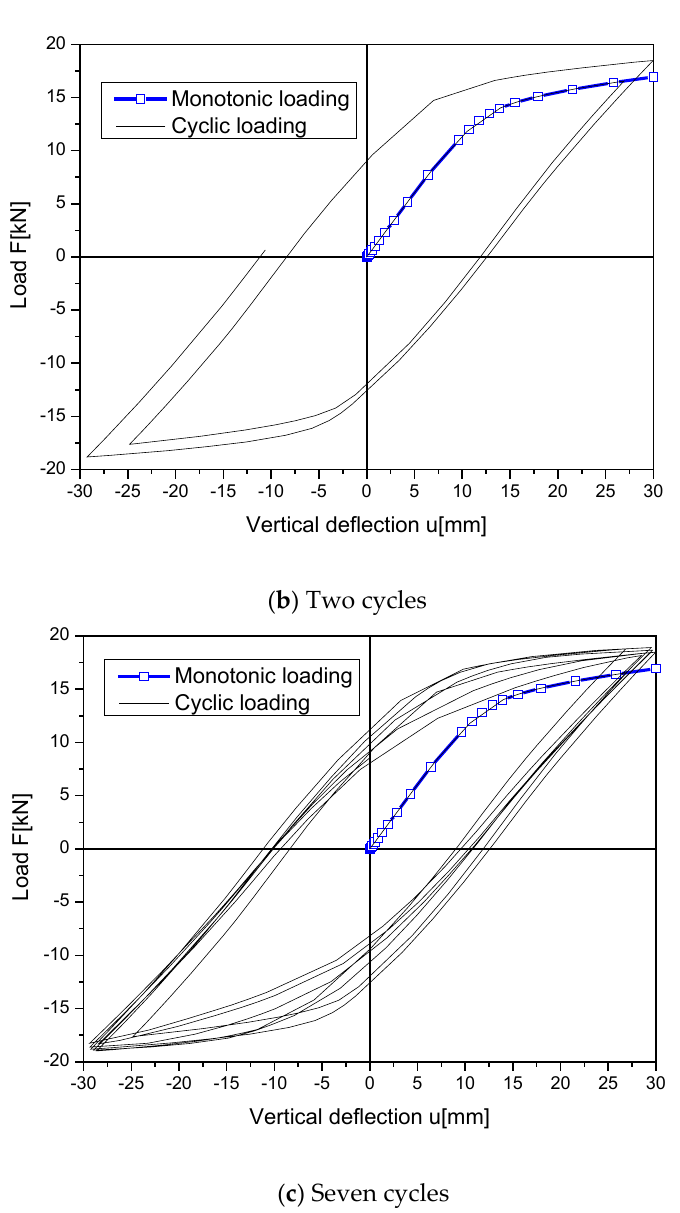
Figure 10. Force displacement curves under cyclic